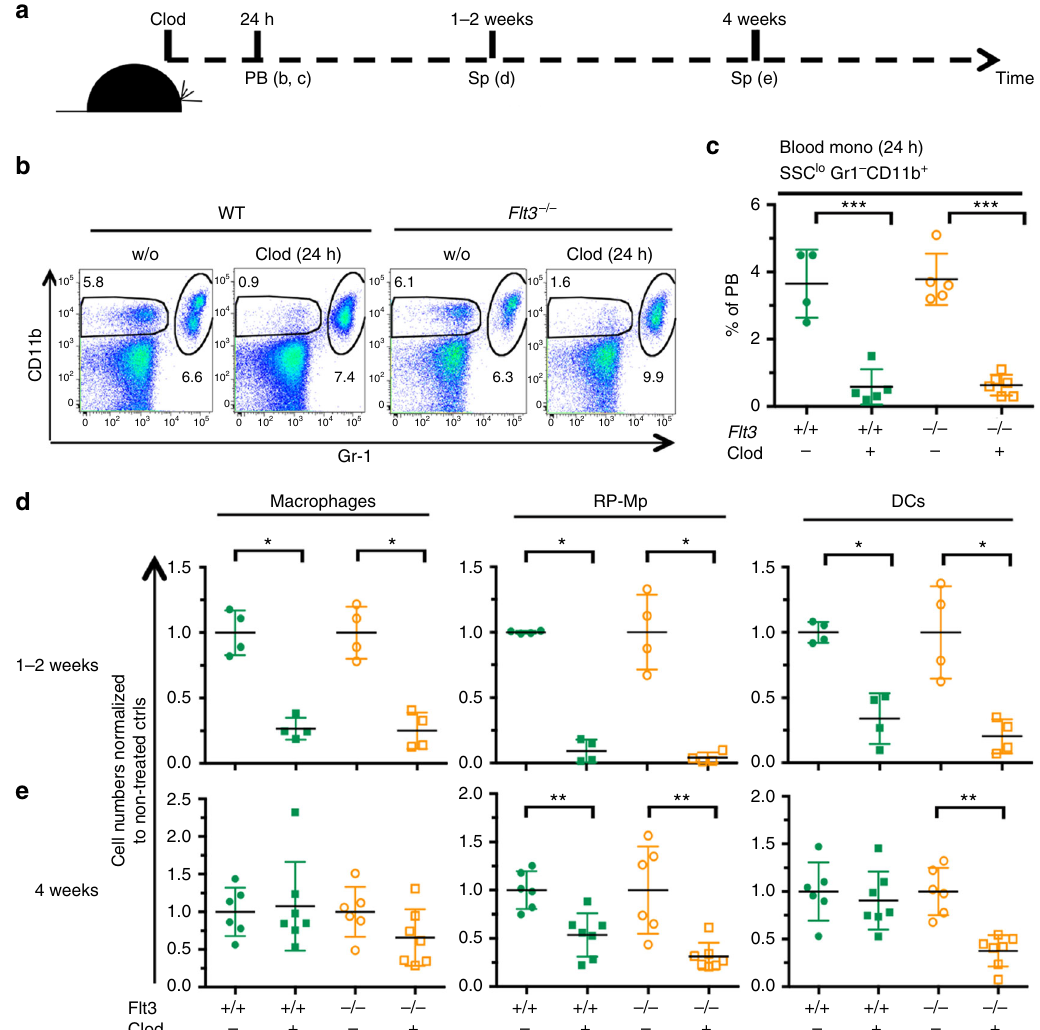
Fig. 5 Depletion of spleen CD11b lo F4/80 hi macrophages in adult FLT3-de fi cient mice results in loss of DCs. a Schematic outline of the experiment. b Clodronate liposomes (Clod) were injected into Flt3 − / − and wild-type (WT) mice and the ef fi cient depletion of blood monocytes (CD11b + Gr-1 lo ) was analyzed 24 h later (left). c Plot shows the reduction of blood monocytes. Data are pooled from two independent experiments. SD is shown. d Cell numbers of spleen macrophages (left), RP-Mps (middle), and DCs (right) normalized to non-injected controls from the same experiments 1 – 2 weeks after Clod injection. All cell types were depleted ef fi ciently. Data are pooled from two independent experiments. SD is shown. e Cell numbers of spleen macrophages (left), RP-Mps (middle), and DCs (right) normalized to non-injected controls from the same experiments 4 weeks after Clod injection. Macrophages recovered in all mice. RP-Mps failed to recover in all mice. DCs recovered in Flt3 -pro fi cient but not in Flt3 -de fi cient mice. Two-sided t tests were performed and SD is shown throughout the fi gure.